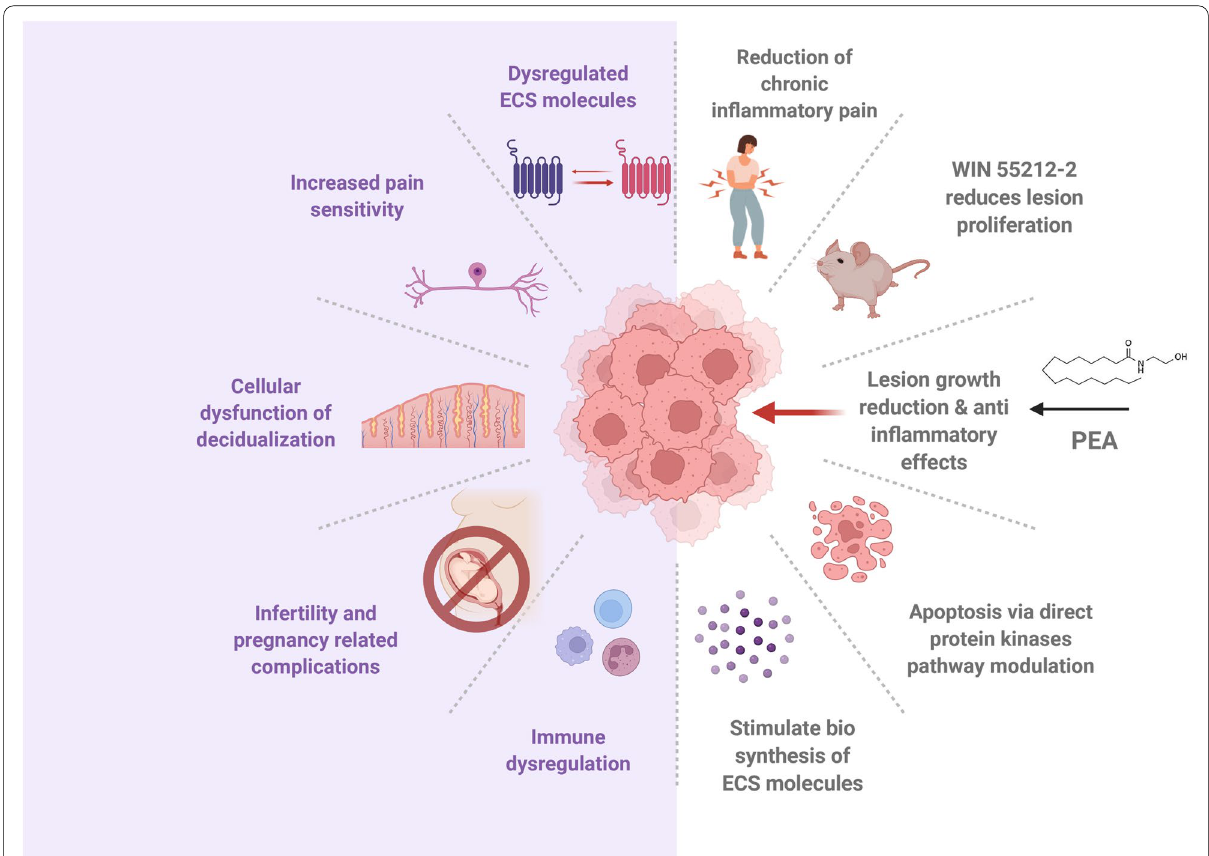
Fig. 3 The endocannabinoid system in endometriosis pathophysiology. EMS has been associated with endocannabinoid dysregulation and deficiency that contributes to increased pain sensitivity, compromised decidualization, infertility, and related complications. Endometriotic lesions produce differential levels of endocannabinoids (ECs) but their role in disease progression versus bystander effect is not entirely known. In vivo studies have shown that synthetic cannabinoids and some ECs (palmitoylethanolamide-PEA) have anti-inflammatory effects and inhibit the proliferation of endometriosis (EMS)-like lesions in